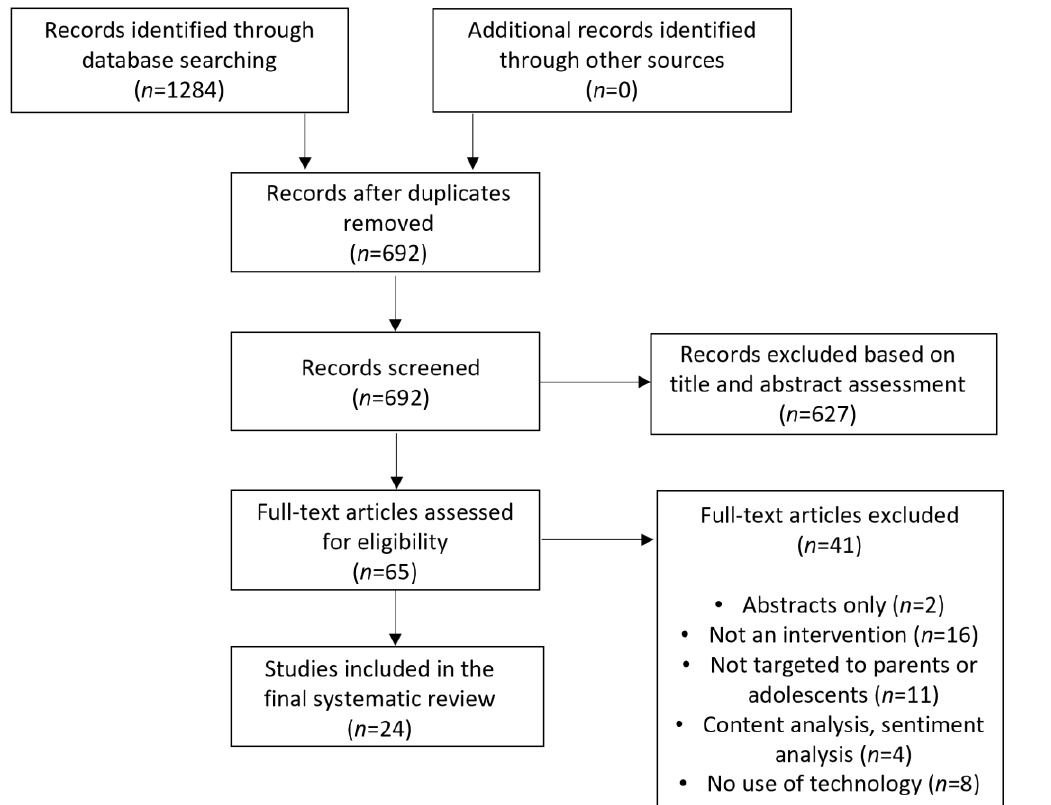
Figure 1. PRISMA flow diagram.